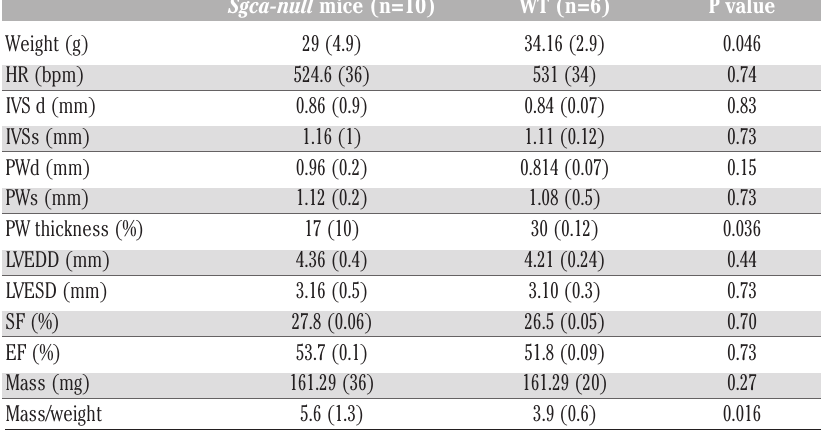
Table 3. Comparison of WT mice and sgca-null mice echocardiographic’s parameters at 17 months of